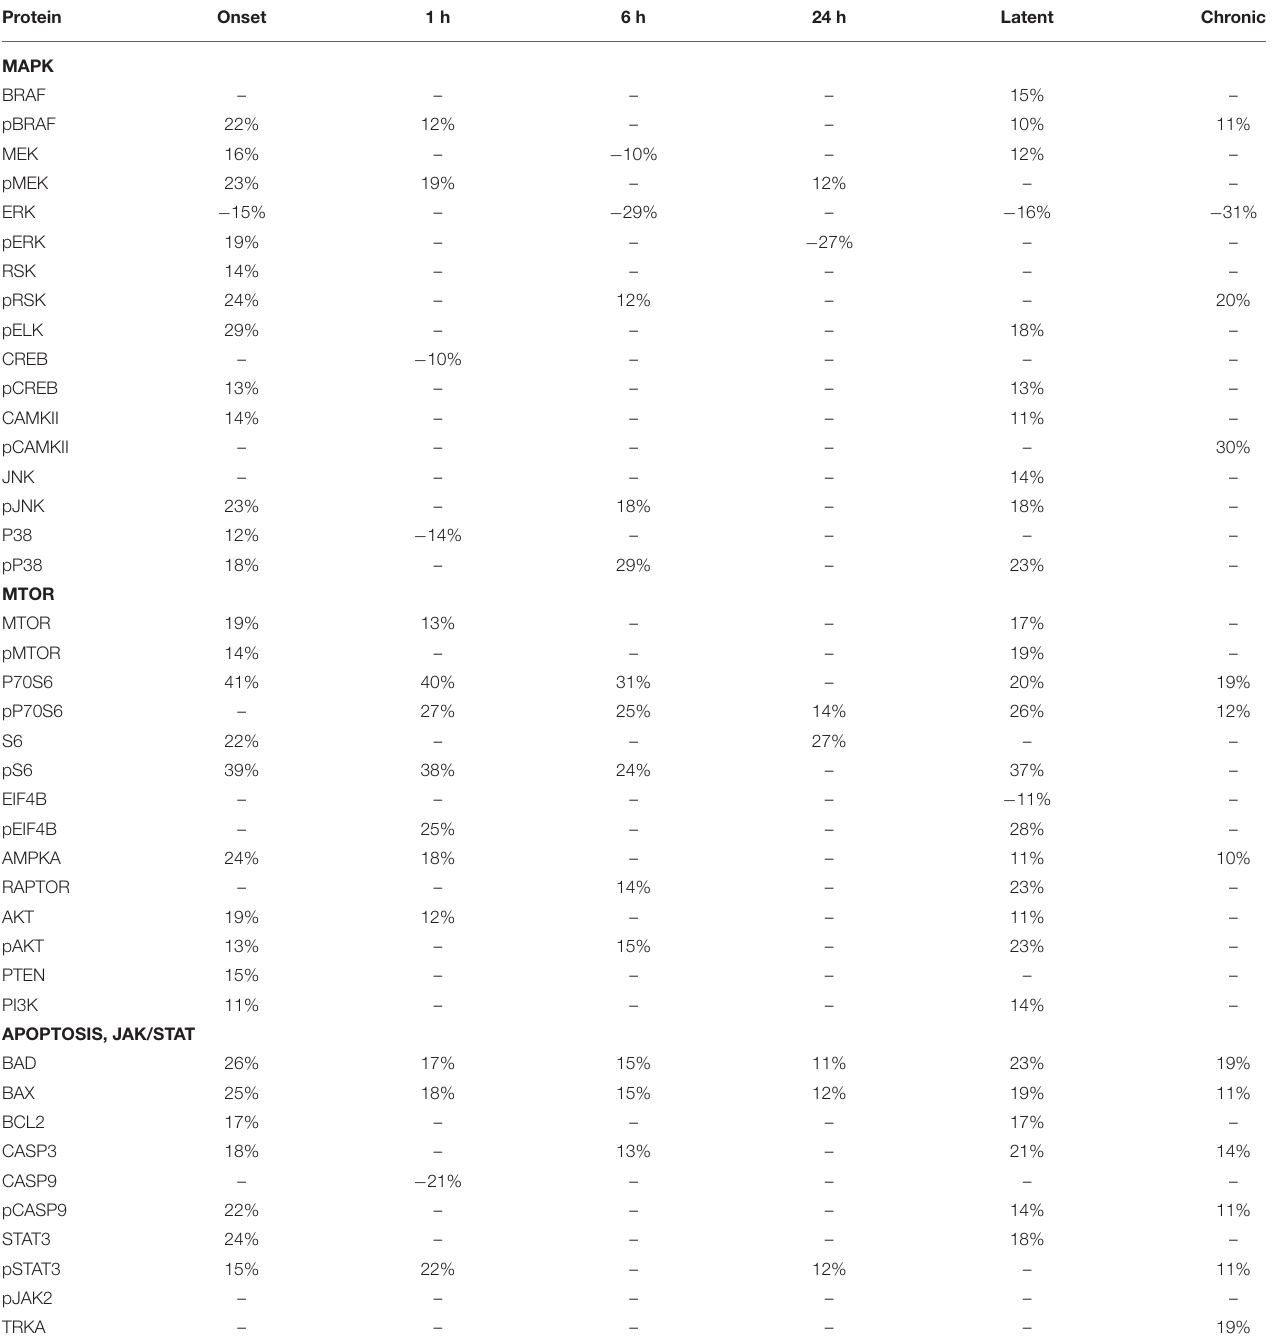
TABLE 5 | Protein changes in cerebellum, MAPK, MTOR, JAK/STAT, and apoptosis pathway components (pilocarpine vs. saline chronic). Protein Onset